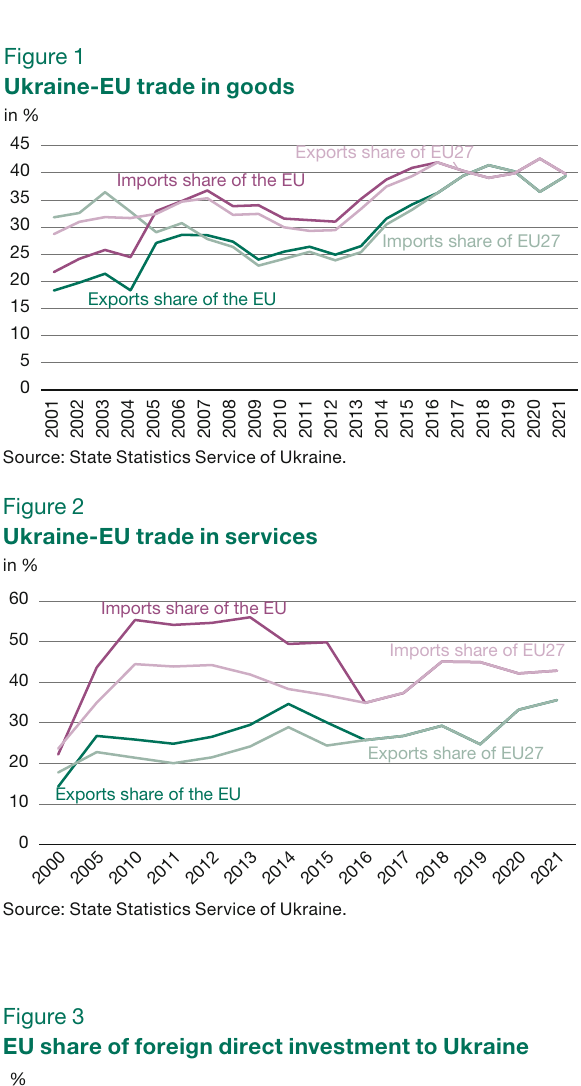
EU share of foreign direct investment to Ukraine